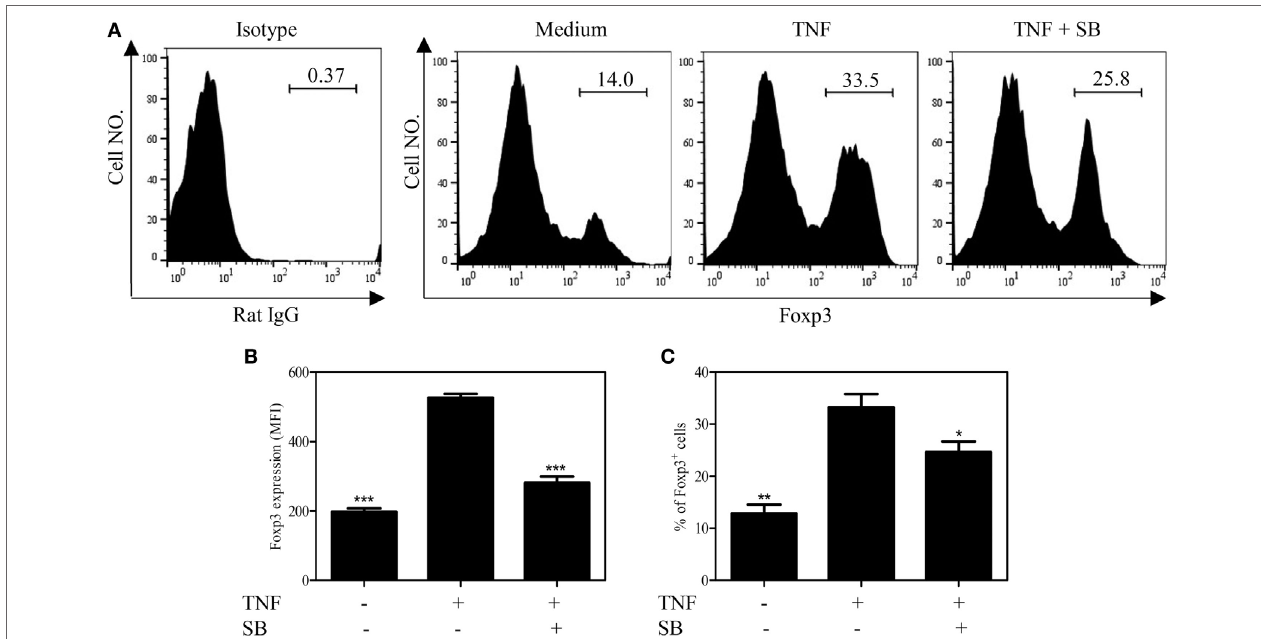
FigUre 4 | SB203580 inhibits Foxp3 expression in tumor necrosis factor (TNF)-treated regulatory T cells. FACS-sorted CD4 + CD25 + T cells were stimulated with plate-bound anti-CD3 and soluble anti-CD28 Abs, in the presence or absence of TNF (10 ng/mL), with or without 25 µM SB203580 for 3 days. Foxp3 expression and ratio of Foxp3 + cells were analyzed by FACS. (a) Typical histograms of Foxp3 expression. Number in the histogram indicates the proportion of gated cells. (B) Summary of Foxp3 expression (MFI. N = 3, means ± SEM). (c) Summary of proportion of Foxp3-expressing cells ( N = 3, means ± SEM). By comparison with TNF group (without SB203580), * p < 0.05, ** p < 0.01, *** p < 0.001. Data shown are representatives of at least three separate experiments with similar